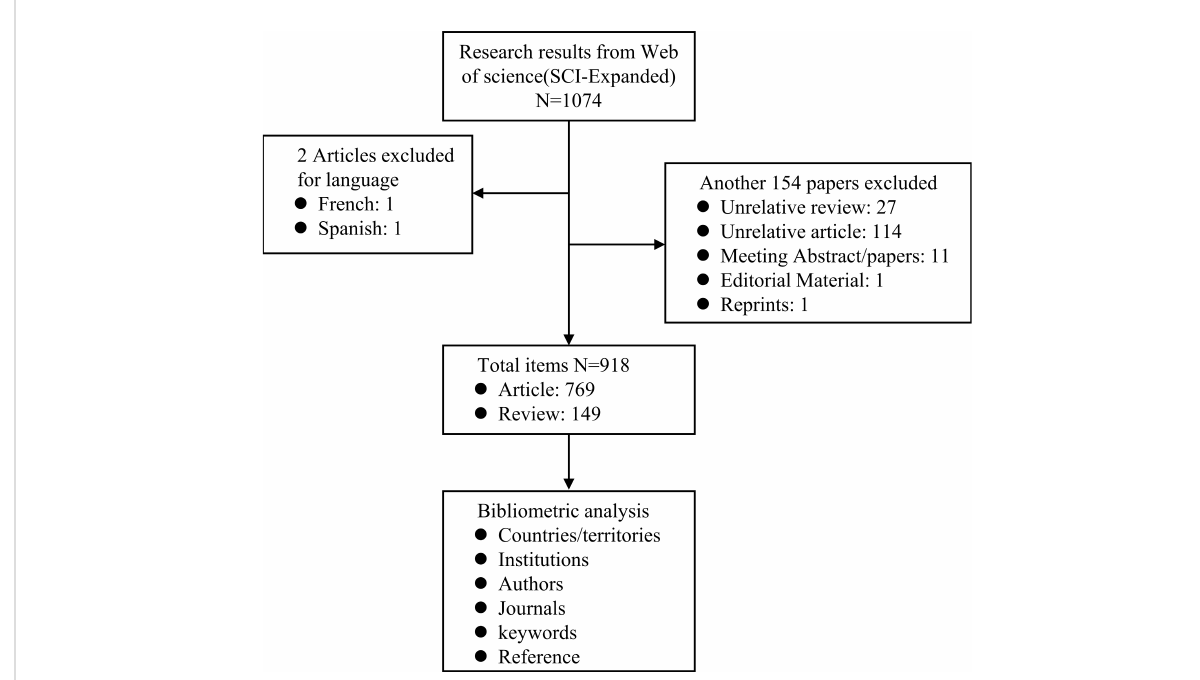
FIGURE 1 Flowchart of the study strategy.